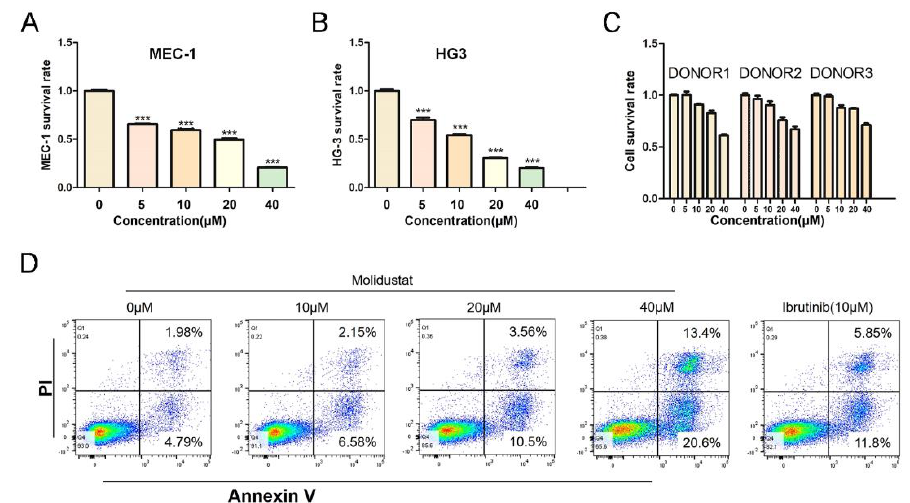
Figure 5. Effect of molidustat on MEC-1 and normal mononuclear cells. ( A , B ) CCK-8 assay of the effects of 0, 5, 10, 20, or 40 µ M of molidustat on the MEC-1 and HG3 cell lines. Molidustat inhib- ited the proliferation of both cell lines in a concentration-dependent manner (*** means p ≤ 0.001). ( C ) CCK-8 assay of the effects of 0, 5, 10, 20, or 40 µ M of molidustat on mononuclear cells in normal human peripheral blood. At these concentrations, molidustat had little effect on peripheral blood mononuclear cells. ( D ) MEC-1 cells were treated with 0, 10, 20, or 40 µ M molidustat and 10 µ M ibrutinib for 48 h, and the apoptosis rate was determined by flow cytometry. The apoptosis rate of MEC-1 cells increased as the concentration of molidustat was increased; 20 µ M molidustat and 10 µ M ibrutinib had comparable effects on the apoptosis rate of MEC-1 cells.